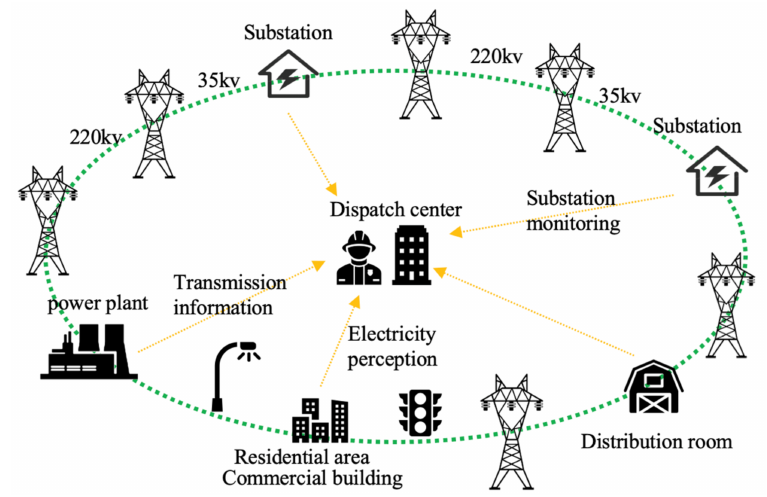
Figure 1. IIoT power communication equipment application scenario diagram.